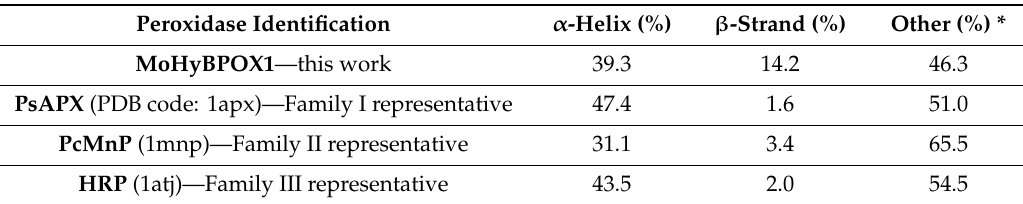
Table 2. Comparison of secondary structure elements deconvoluted from far-UV CD spectrum for Hybrid B peroxidase 1 from Magnaporthe oryzae (MoHyBPOX1) with typical representatives from all three families of the Peroxidase-Catalase superfamily.